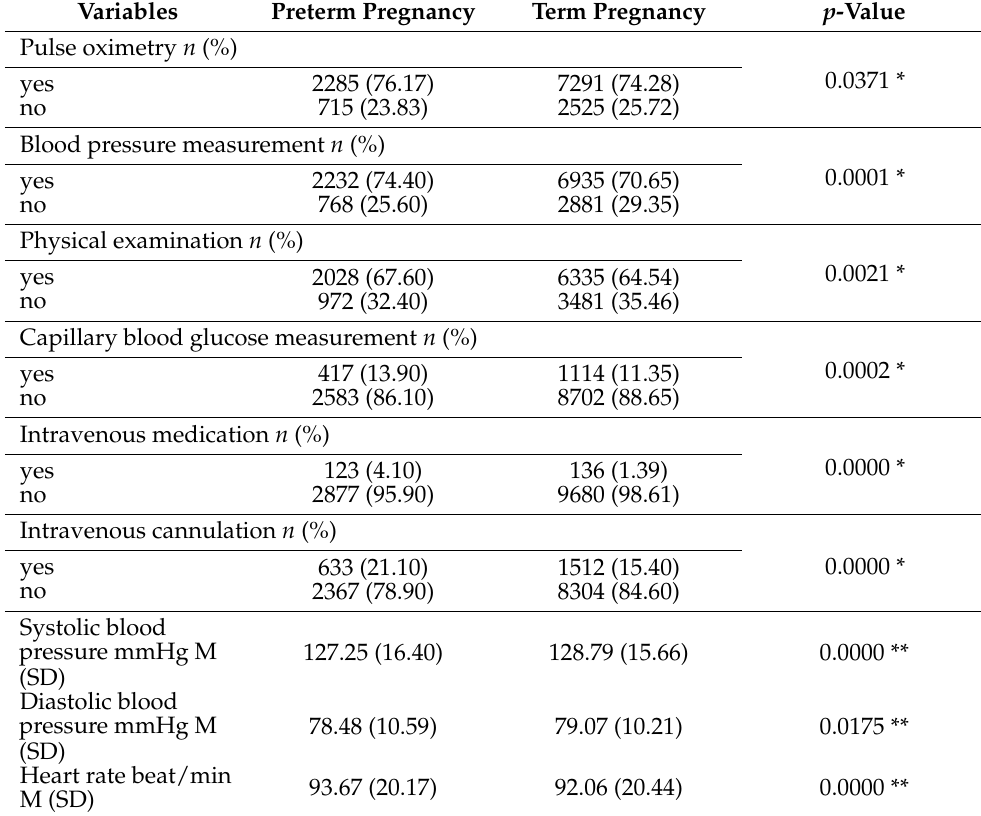
Table 5. Analysis of associations between duration of pregnancy and the emergency medical proce- dures performed and selected physical examination